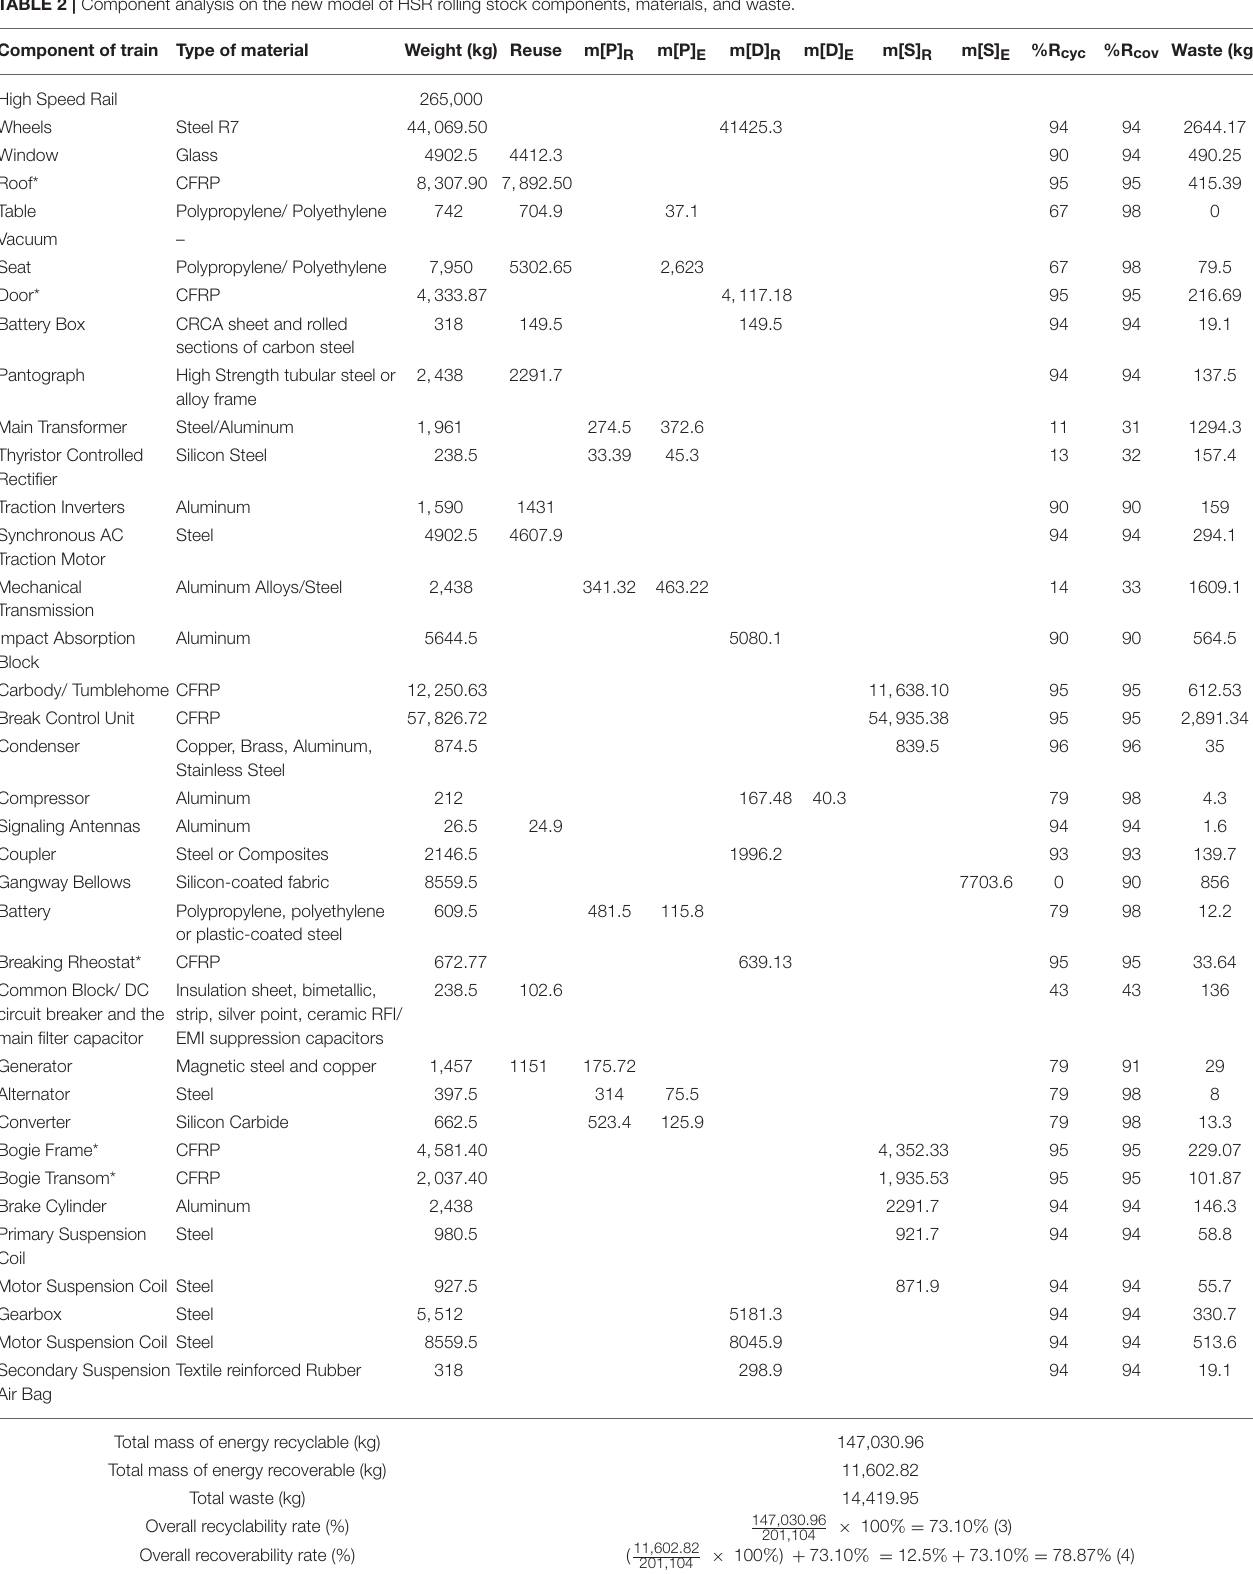
TABLE 2 | Component analysis on the new model of HSR rolling stock components, materials, and waste. Component of train Type of